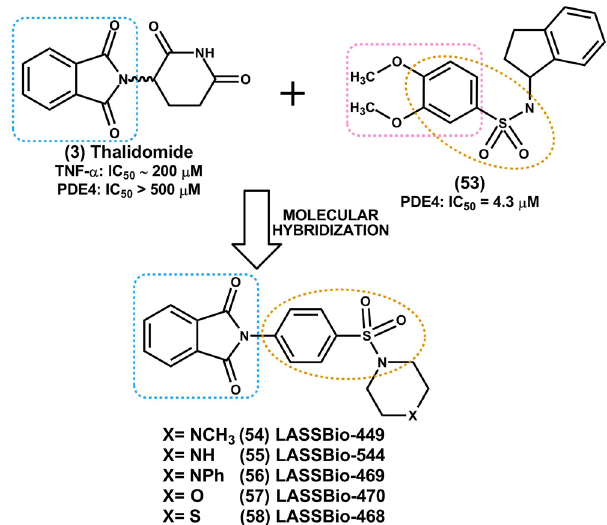
FIGURE 6 - Structural design of the N -phenyl sulfonamide phthalimidic derivatives, idealized as dual inhibitors of TNF-α and PDE4 (Lima et al. ,